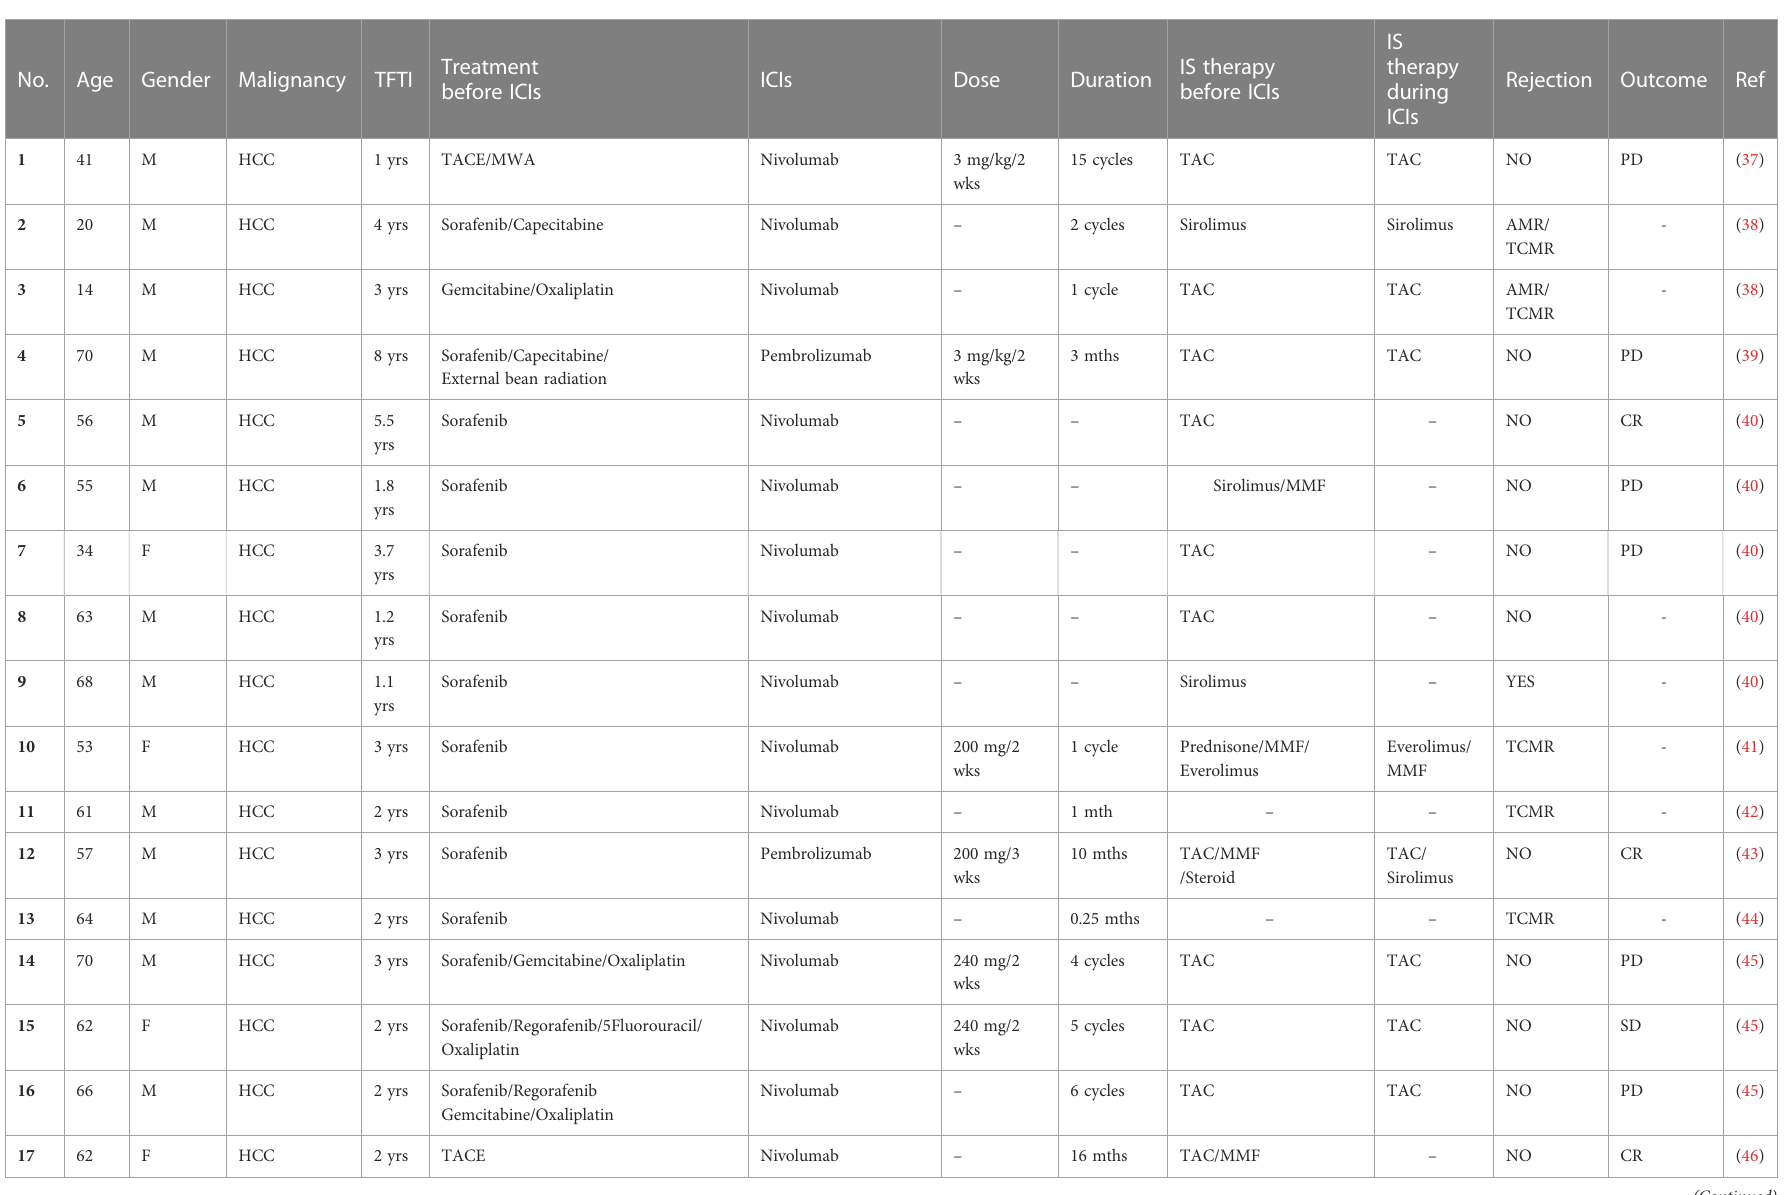
TABLE 1 Case reports with the application of ICIs in HCC recurrence patients after